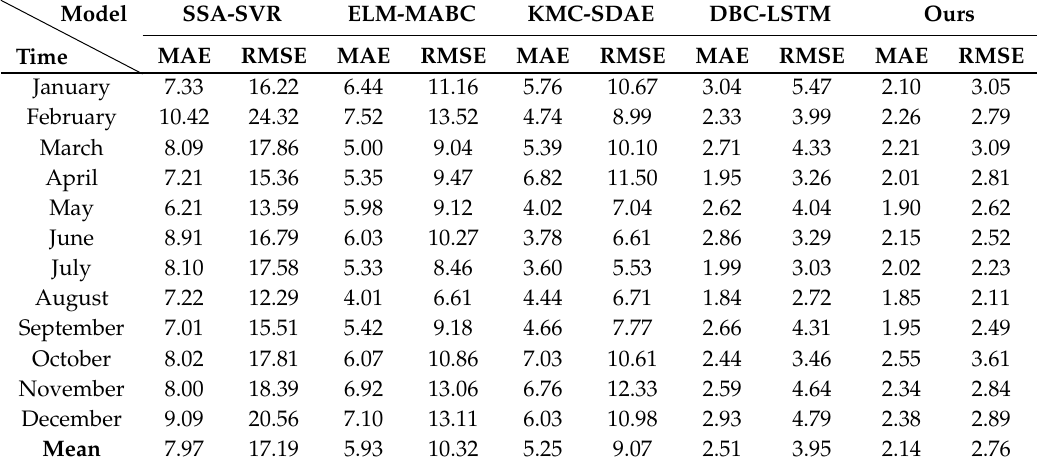
Table 3. Forecast errors of different models. SDAE, stacked denoising autoencoder.